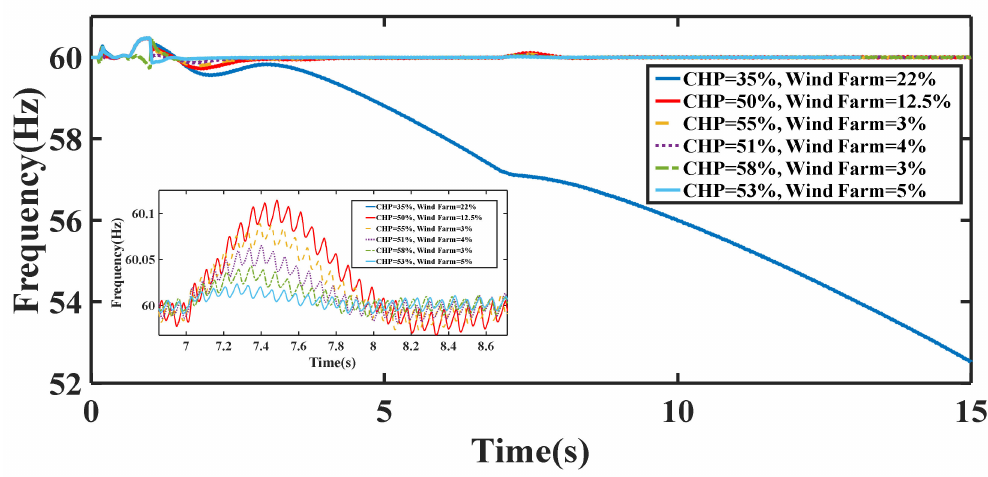
Figure 16. Frequency devotion due to the 30% reduction in system inertia for different combinations of inverter-based and droop-based